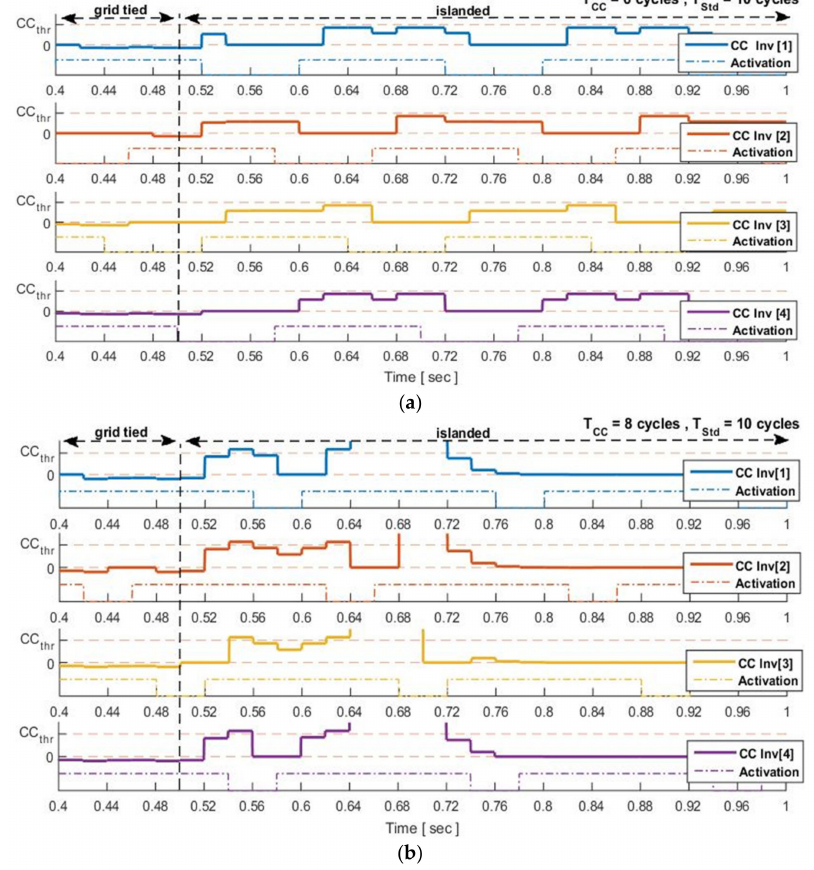
Figure 8. CC index of inverters under nominal power operation, ( a ) l = 3 ( T CC = six cycles), ( b ) l = 4 ( T CC = eight